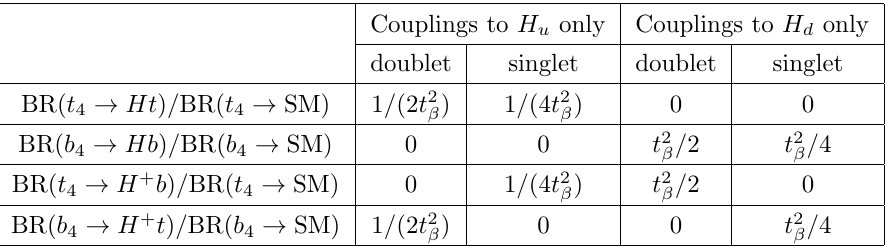
Table 6 . Branching ratios of the vectorlike quarks ( t 4 ; b 4 ) into ( H; H (cid:6) ) normalized to the total branching ratio into SM particles ( W , Z and h ) as a function of t (cid:12) = tan (cid:12) . These expressions are exact for heavy vectorlike masses and in the limit in which the couplings in table 2 dominate.